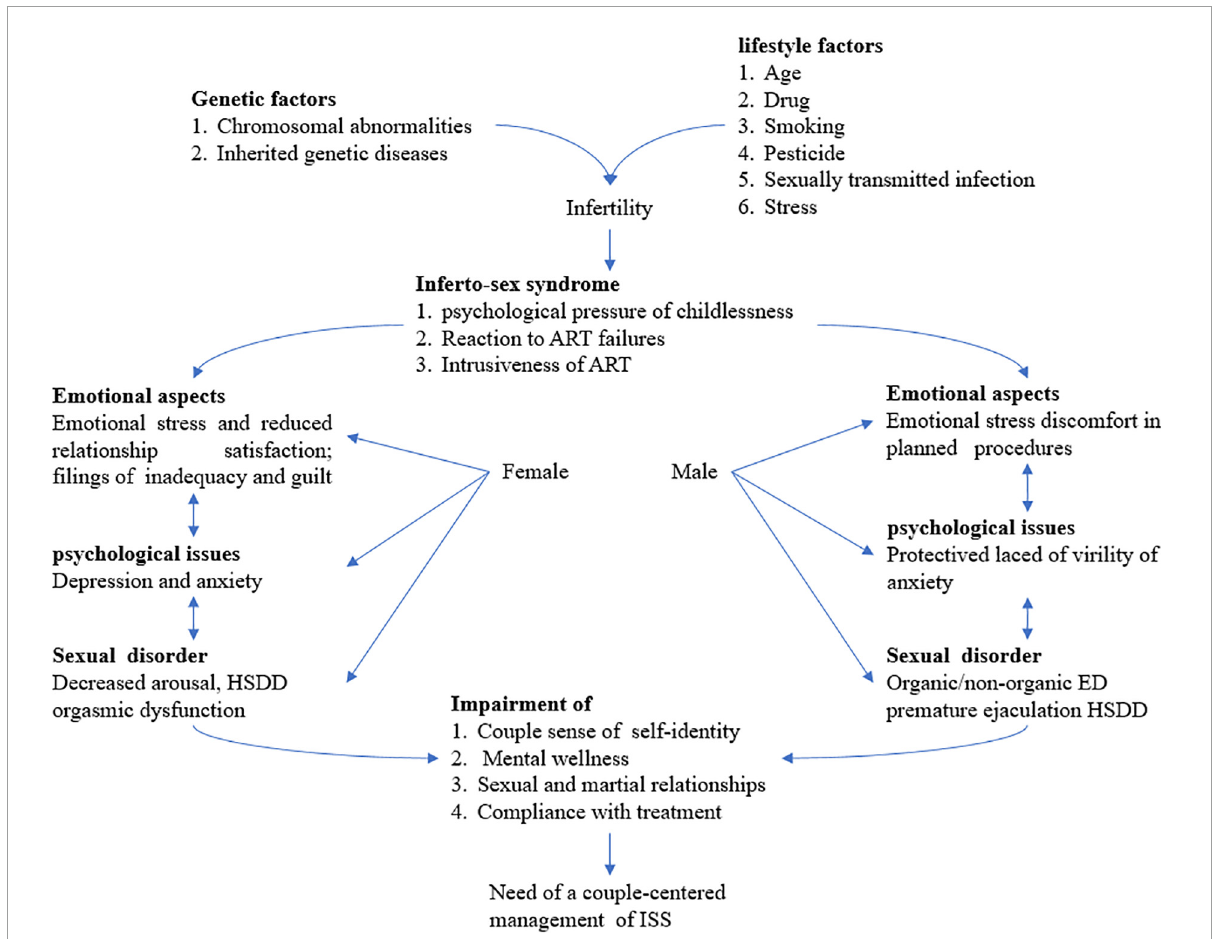
FIGURE1 Infertility is a real challenge as a couple disorder and sexual dysfunction is an emerging paradigm. A couple-centered approach for the treatment for infertility is mandatory requiring a multidisciplinary team for the comprehensive management of ISS including the whole sexual, rational, and emotional aspects of infertile couples. ART assisted reproductive technology, ED erectile dysfunction, HSDD hypoactive sexual desire disorder, and ISS Inferto-Sex Syndrome. This figure is adapted from Luca et al.